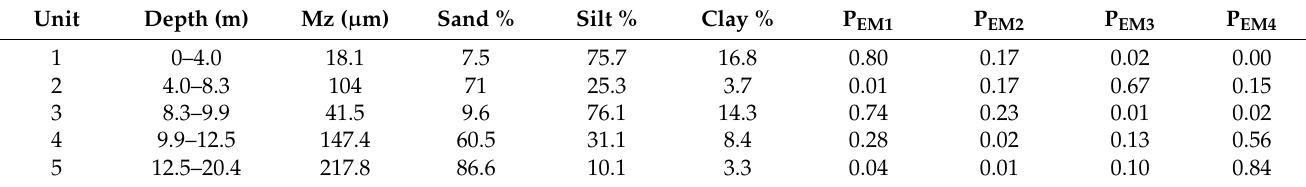
Table 2. The grain-size composition of core HDZ04 and the average scores of the four EMs in relation to